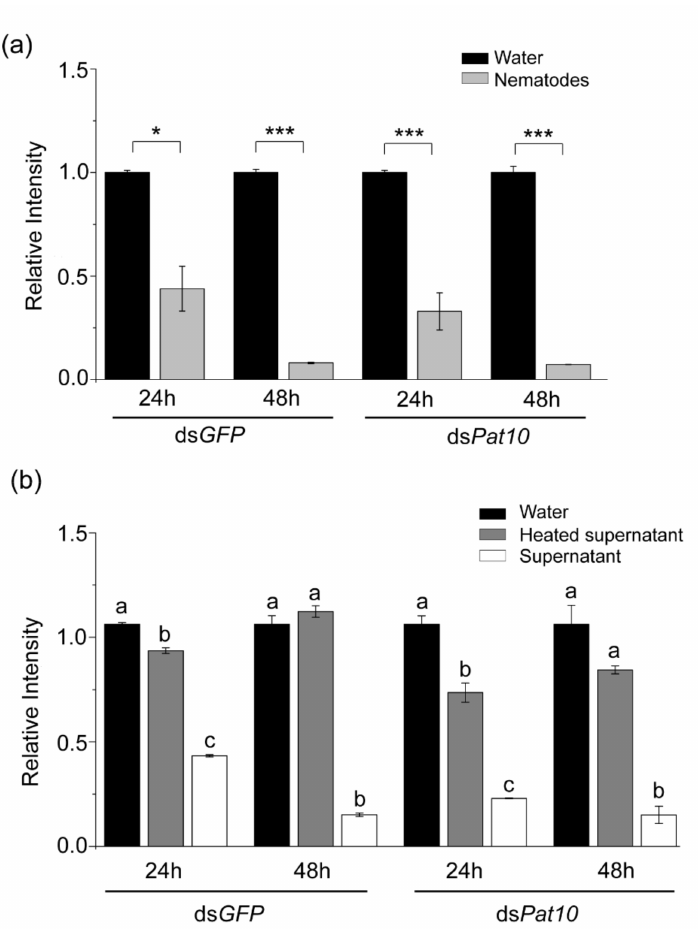
Figure 1. Relative intensity of agarose gel electrophoretic bands. ( a ) The relative intensity of elec- trophoretic bands after dsRNA and nematodes soaked for 24 and 48 h. ( b ) The relative intensity of electrophoretic bands after dsRNA and nematode secretions soaked for 24 and 48 h. Relative intensity differences between two groups were calculated using the independent samples t test. Data are presented as mean ± SE, *** p < 0.001; * p < 0.05; different letters indicate significant difference ( p < 0.05).